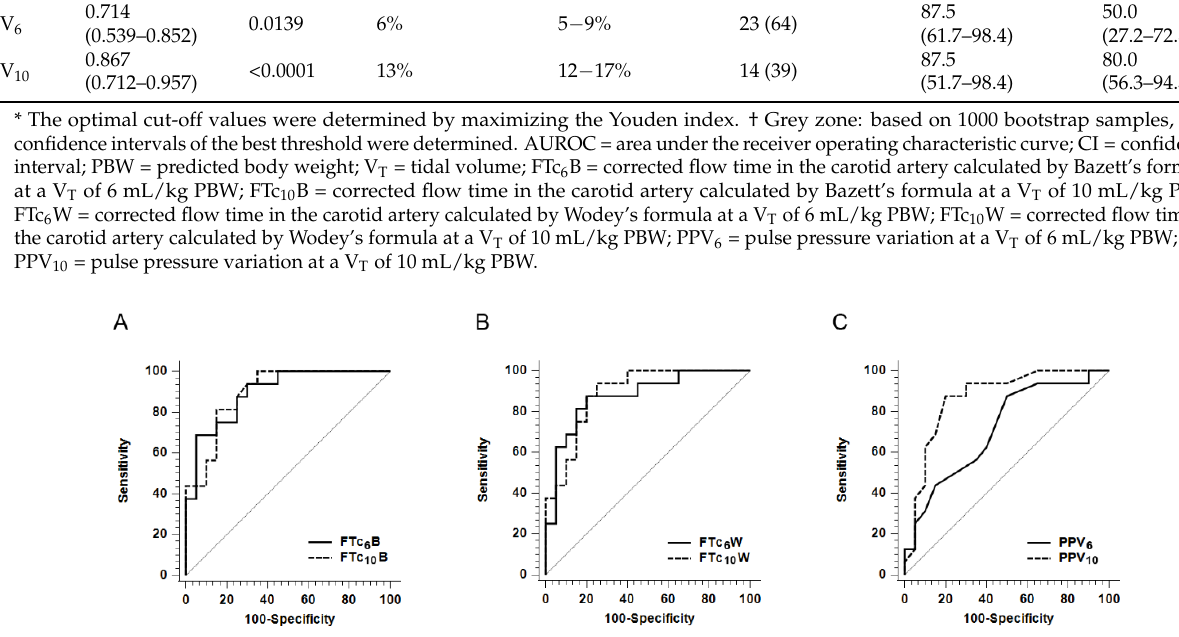
Figure 2. Receiver operating characteristic curves comparing the ability of various parameters to predict the fluid re- sponsiveness. ( A ) FTc6B vs. FTc10B. ( B ) FTc6W vs. FTc10W. (C) PPV6 vs. PPV10. The area under the receiver operating characteristic curve for PPV6 was only significantly lower than that of PPV10 ( p = 0.034). FTc6B = corrected flow time in the carotid artery calculated by Bazett’s formula at tidal volume (VT) of 6 mL/kg predicted body weight; FTc10B = corrected flow time in the carotid artery calculated by Bazett’s formula at VT of 10 mL/kg predicted body weight; FTc6W = corrected flow time in the carotid artery calculated by Wodey’s formula at VT of 6 mL/kg predicted body weight; FTc10W = corrected flow time in the carotid artery calculated by Wodey’s formula at VT of 10 mL/kg predicted body weight; PPV6 = pulse pressure variation at VT of 6 mL/kg predicted body weight; and PPV10 = pulse pressure variation at VT of 10 mL/kg predicted body weight.